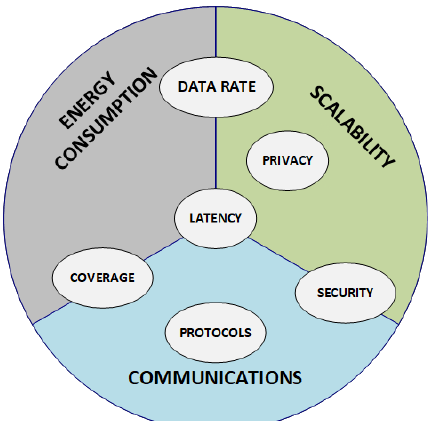
Figure 3. Overview of the main challenges facing WSN technology. The most significant challenges contain other related